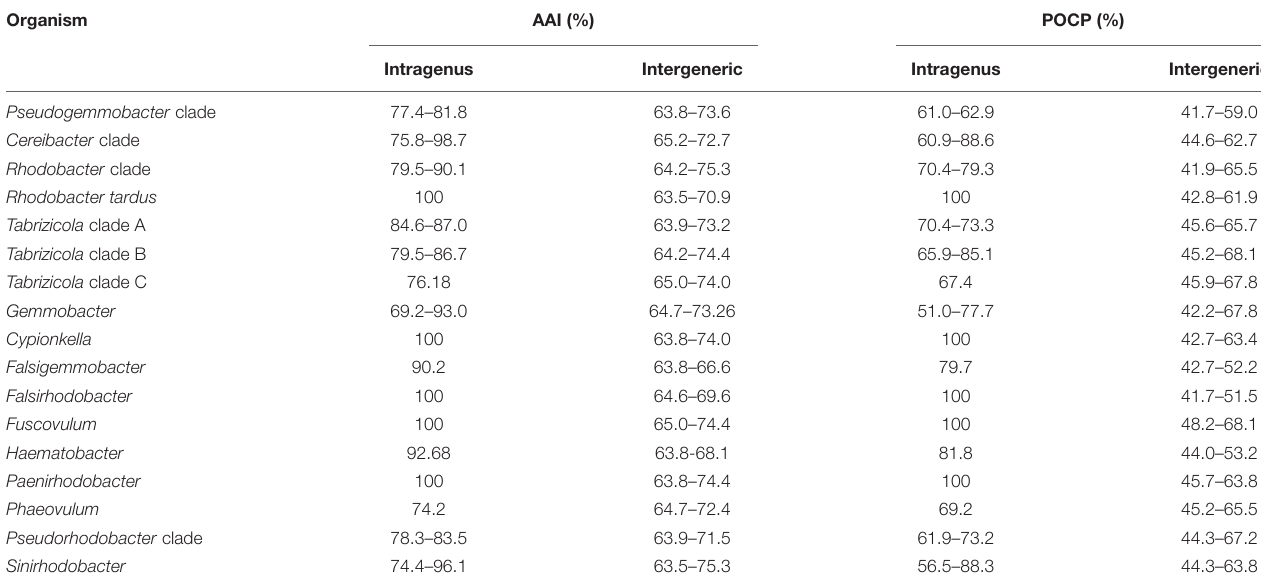
TABLE 4 | Average amino acid identity (AAI) values and percentage of conserved protein (POCP) values of all strains for the intragenus and intergeneric comparisons.